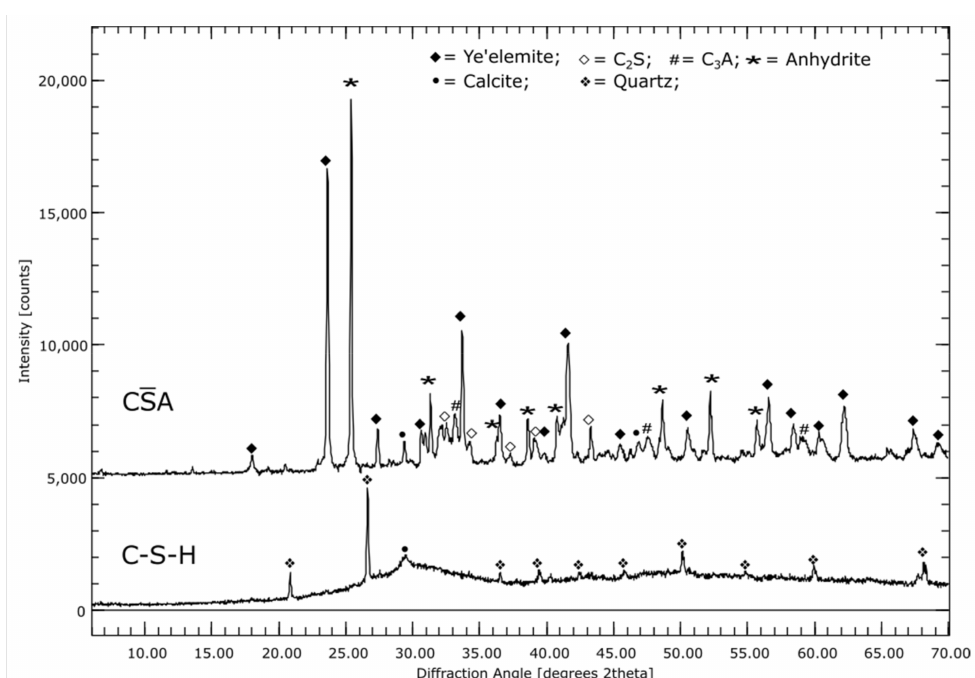
Figure A3. Graphical representation of XRD measurements: CSA and C-S-H.